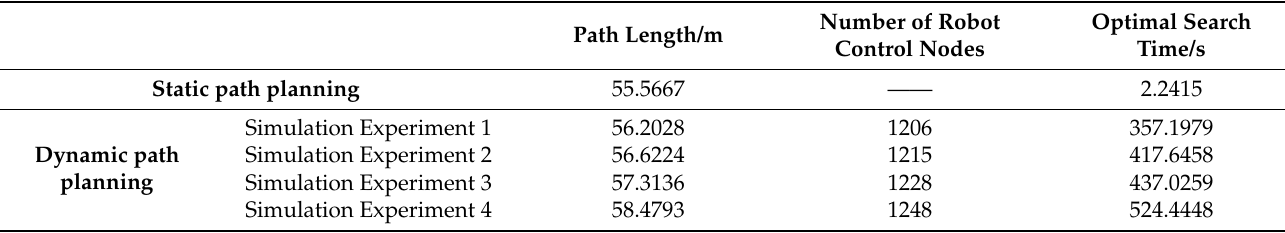
Figure 26. Robot path planning process in a dynamic environment; ( a ) Simulation Experiment 1; ( b ) Simulation Experiment 2; ( c ) Simulation Experiment 3; and ( d ) Simulation Experiment 4. Table 9. Comparison table of robot